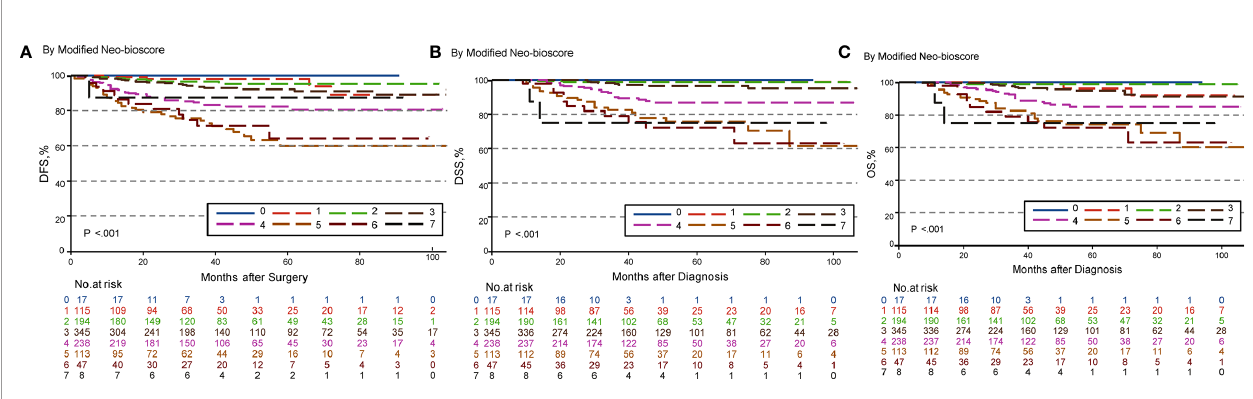
FIGURE 7 | Kaplan – Meier survival curves determined by modi fi ed Neo-Bioscore in patients with breast cancer receiving preoperative systemic therapy (PST). (A) Disease free survival (DFS); (B) Disease speci fi c survival (DSS); (C) Overall survival (OS).